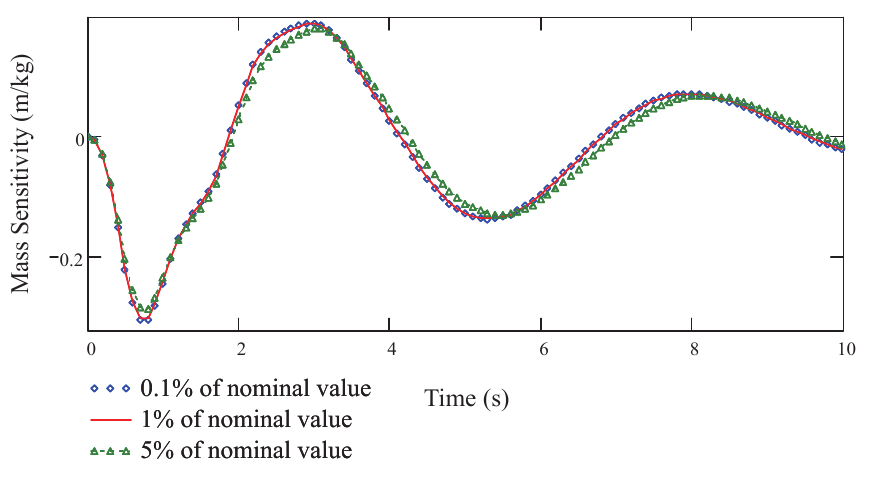
Fig. 5. Mass sensitivity convergence